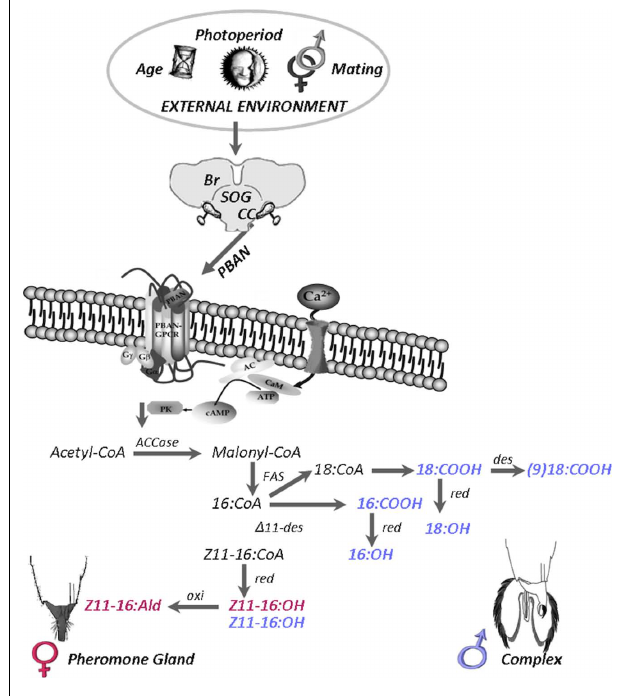
FIGURE 3 |A diagrammatic representation of sex pheromone biosynthesis resulting from PBAN release into the hemolymph and its interaction with the PBAN GPCR in female pheromone glands (PG) and male hairpencil–aedaegus-complexes of Helicoverpa armigera. Up-regulation of female components in red and male components in blue. (Male-complex illustration taken from Bober and Rafaeli, 2010 with permission). Abbreviations: AC, adenylate cyclase; ACCase, acetyl-CoA carboxylase; Br, brain; CaM, calcium–calmodulin; cAMP, cyclic-AMP; CC, corpora cardiaca; Δ 11-des, Δ 11 desaturase; FAS, fatty acid synthetase; GPCR, G-protein coupled receptor; oxi, oxidase; PBAN, pheromone biosynthesis activating neuropeptide; PK, protein kinase A; red, reductase; SOG, subesophageal